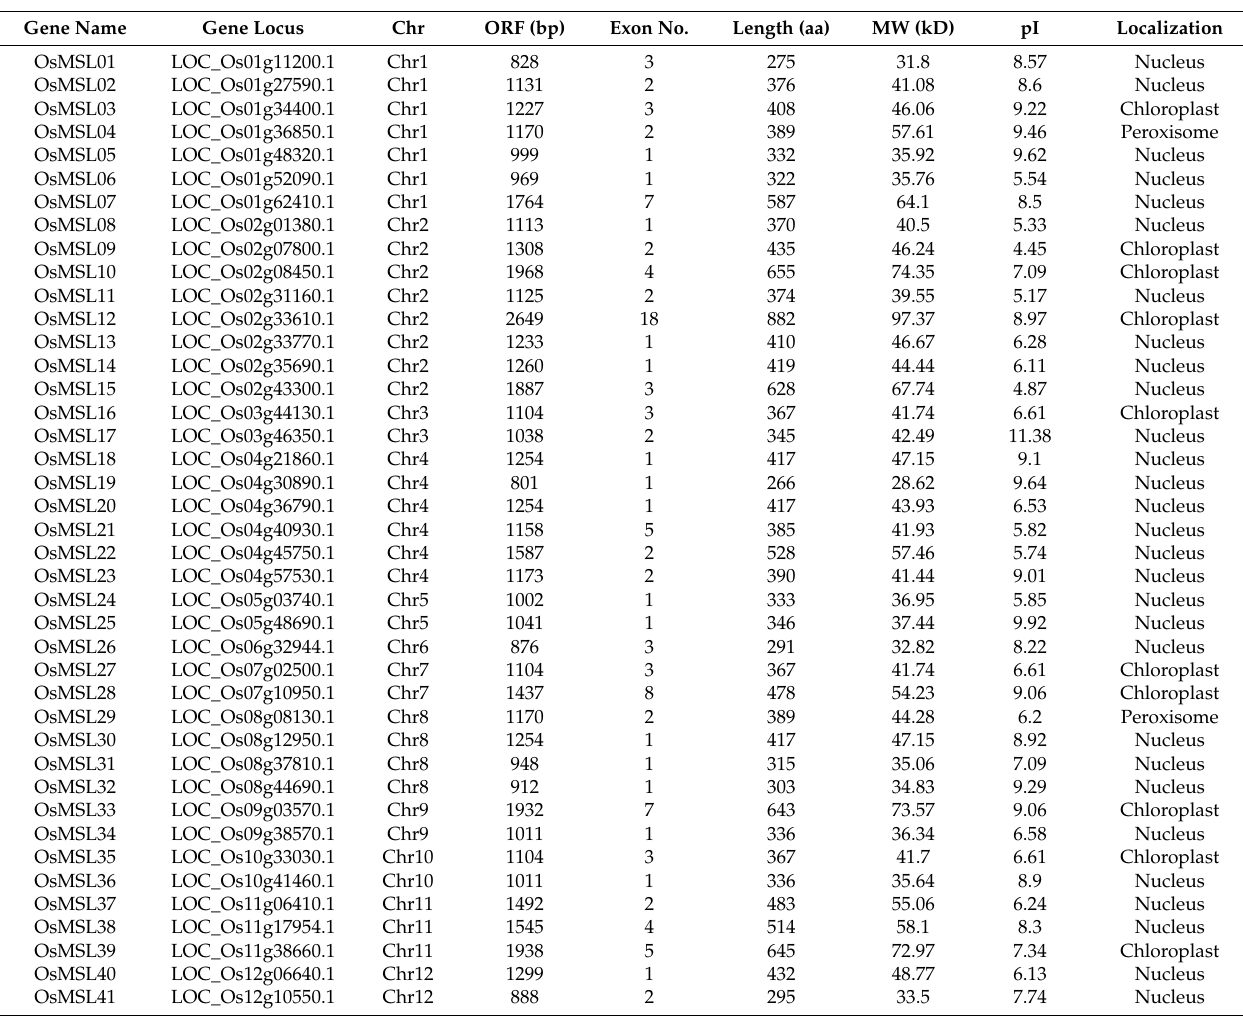
Table 1. Detailed information of all trihelix family genes identified in the rice